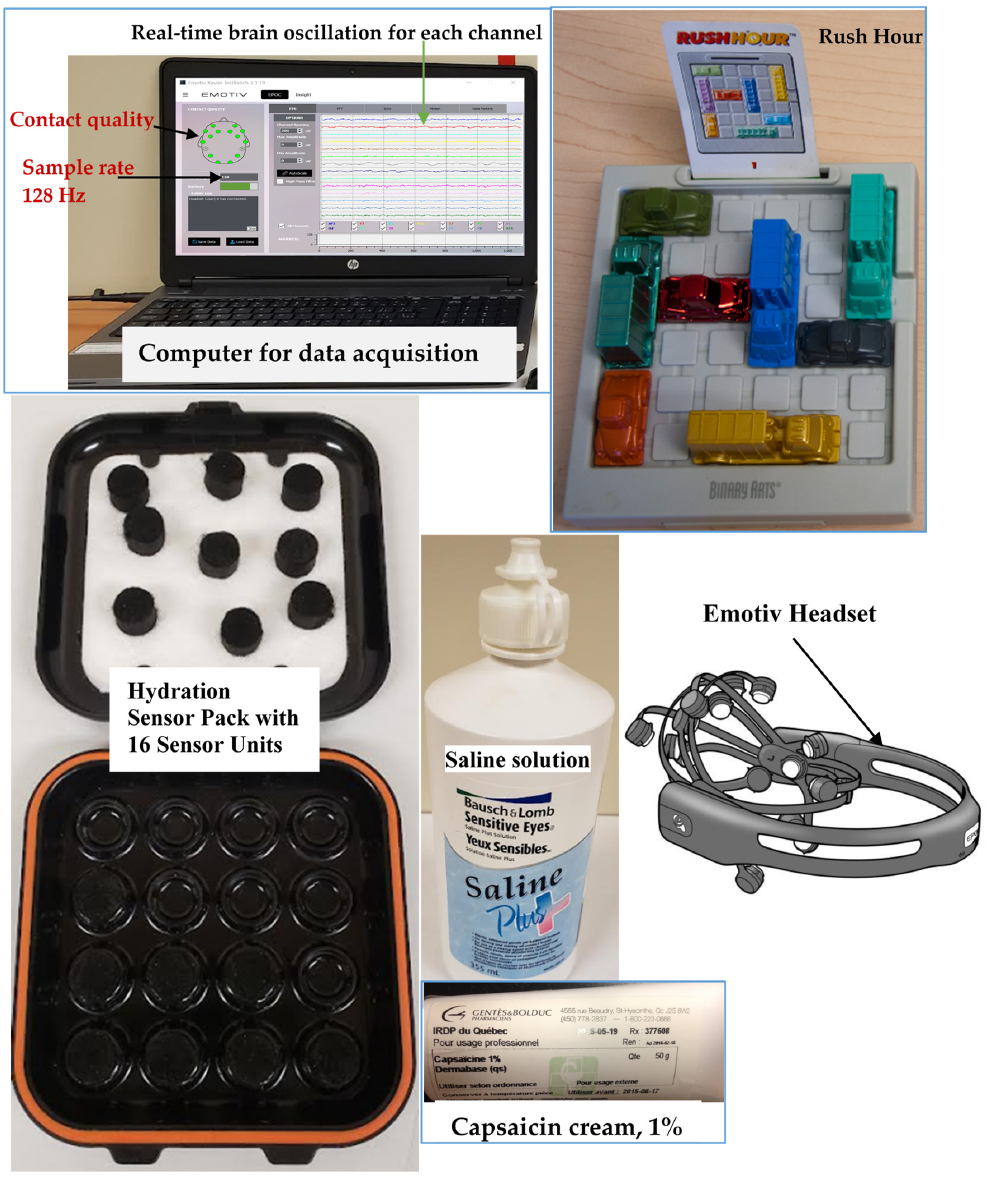
Figure 2. Equipment for data